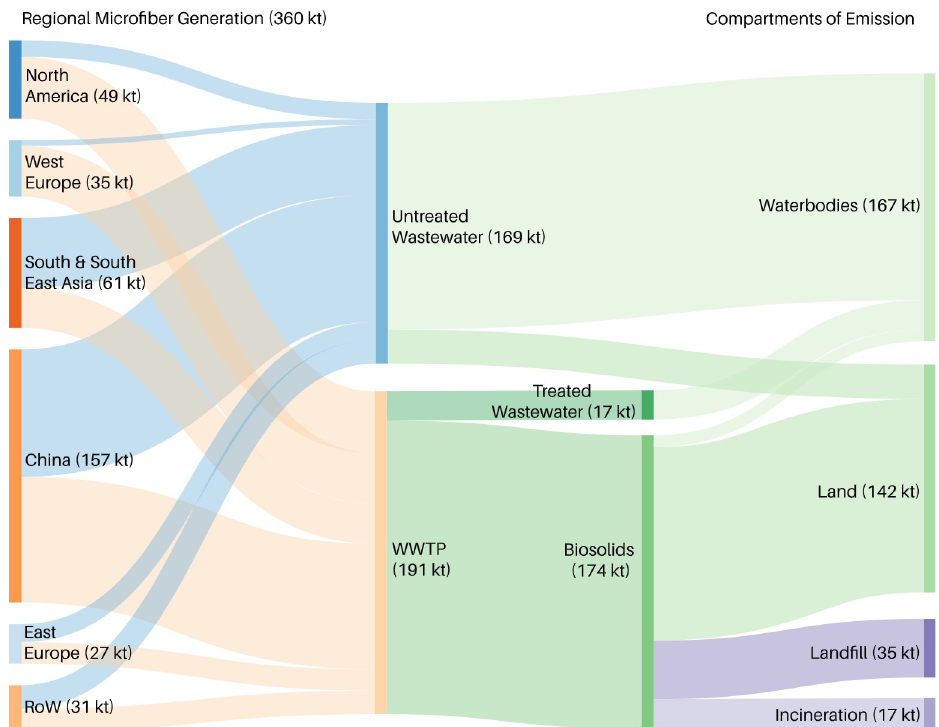
Fig 2. The emission pathways of synthetic microfibers generated from apparel washing in 2016. The leftmost column represents regional microfiber release. The middle columns represent the flow of synthetic microfibers through available infrastructure. The rightmost column represents the initial receiving environmental